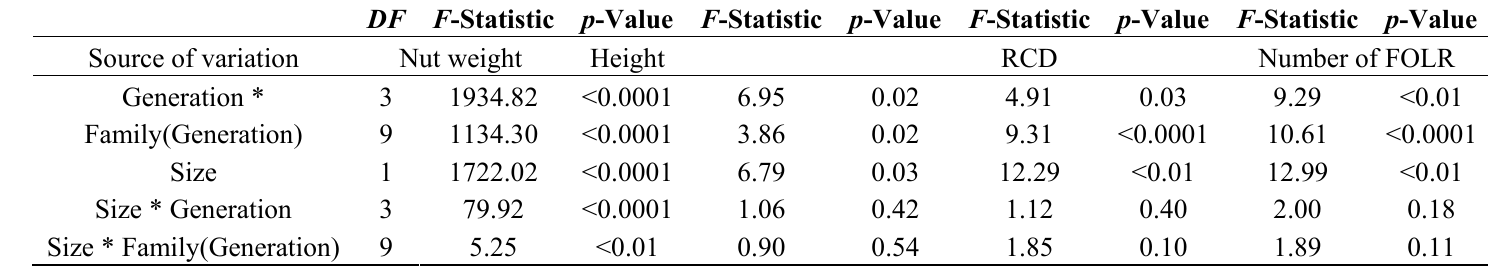
Table 3. Analysis of variance to determine differences and interactions among breeding generations, families, and nut size classes for nut weight ( n = 2691), height ( n = 1741), root-collar diameter (RCD) ( n = 1741) and number of first-order lateral roots (FOLR) ( n = 1589).